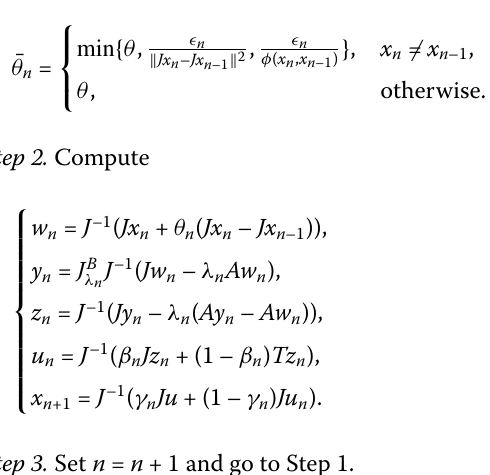
Algorithm 3.1 Inertial Halpern–Tseng-type